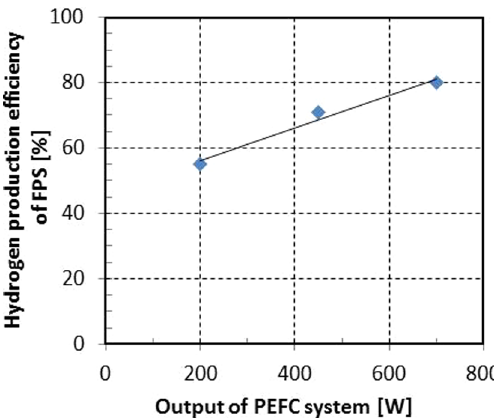
Fig. 2. Partial load ef fi ciency of the FPS.